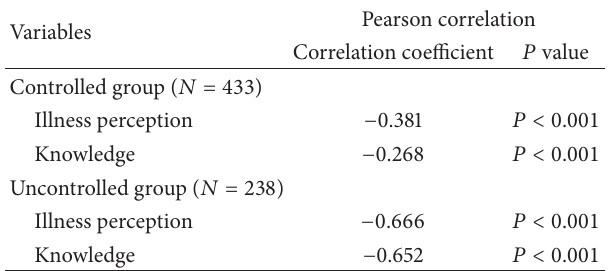
Table 4: Correlation of knowledge and illness perception with sodium